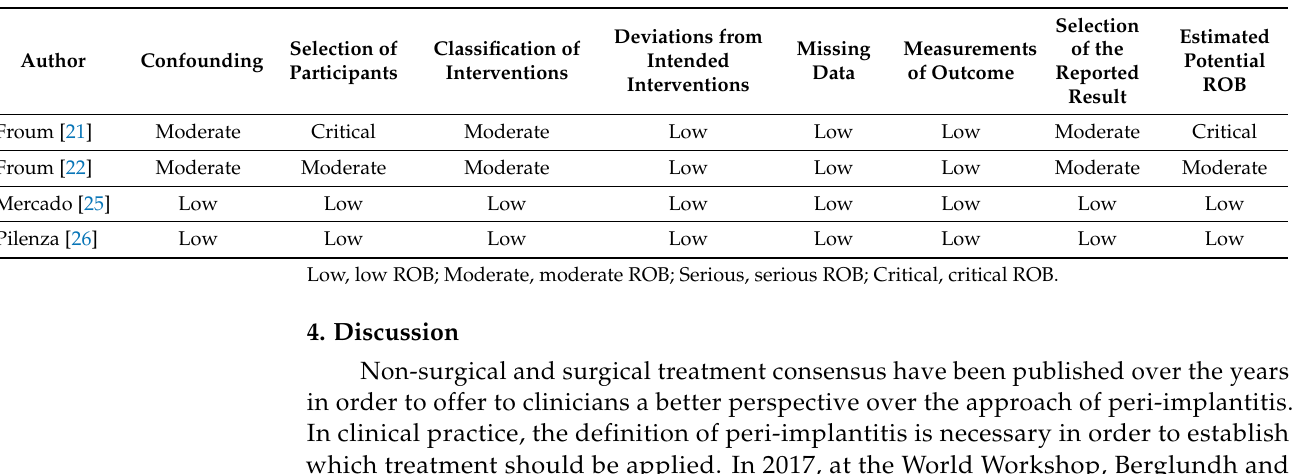
Table 3. ROBINS-I for